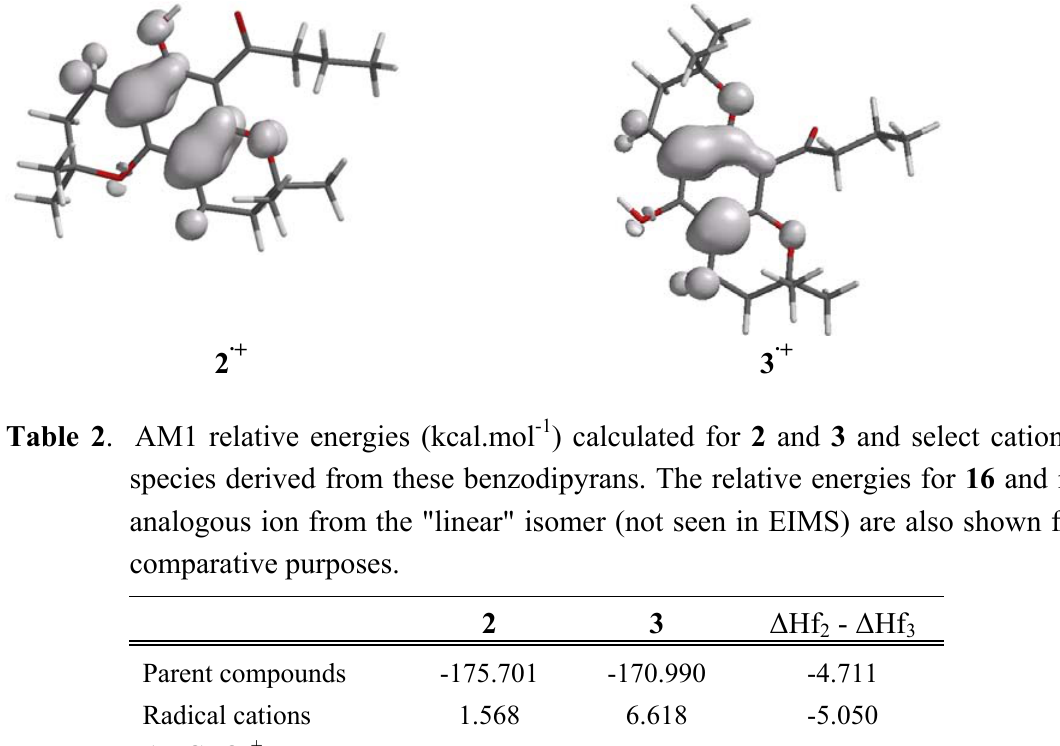
Figure 5 . Spin density maps of the radical cations 2 .+ and 3 .+ .